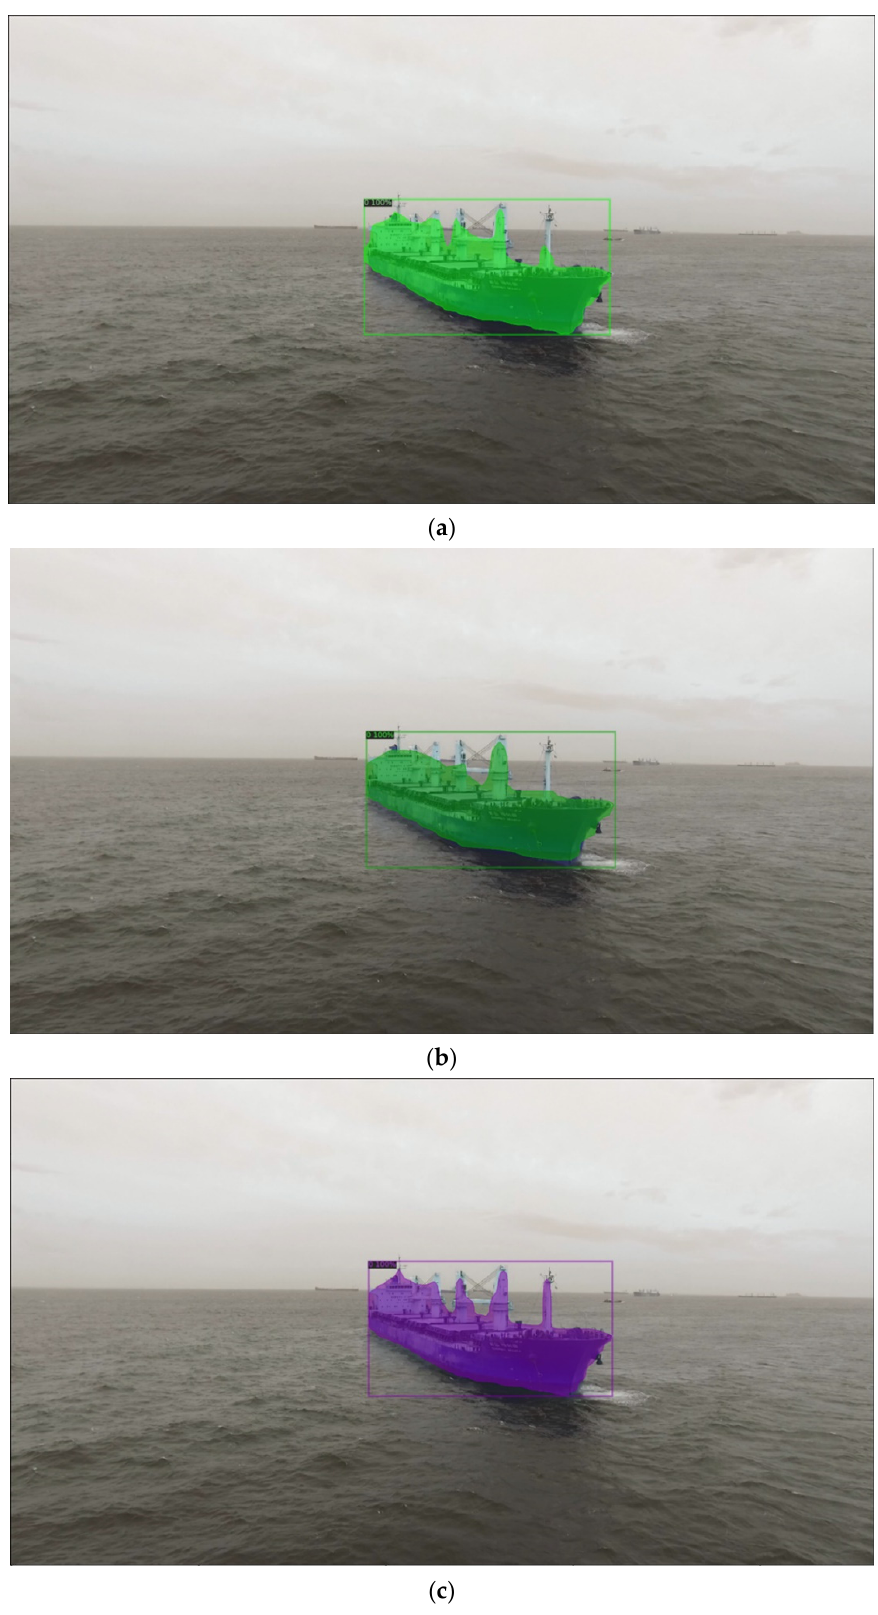
Figure 8. Comparison of the Segmentation Test Results of the Mask R-CNN Model. ( a ) Segmentation Result R50-C4 3x; ( b ) Segmentation Result of R50-DC5 3x; ( c ) Segmentation Result of R50-FPN